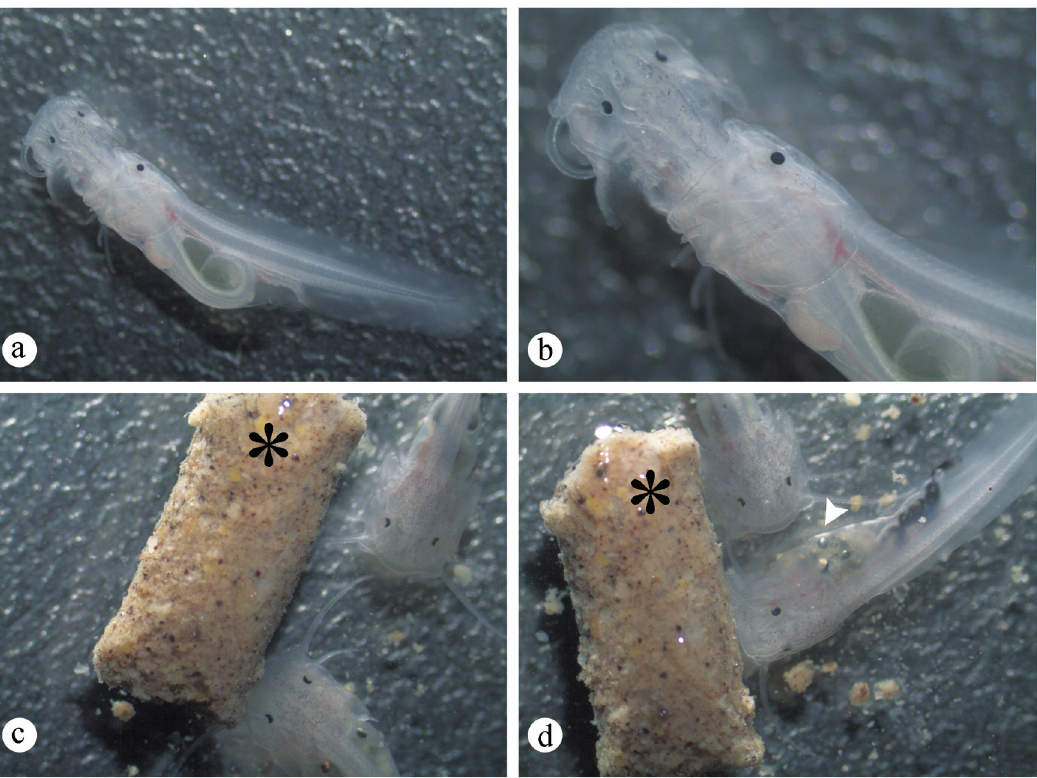
Fig. 5. Macroscopic aspects of larval development of Steindachneridion parahybae . a-b ) cannibalism among the S.